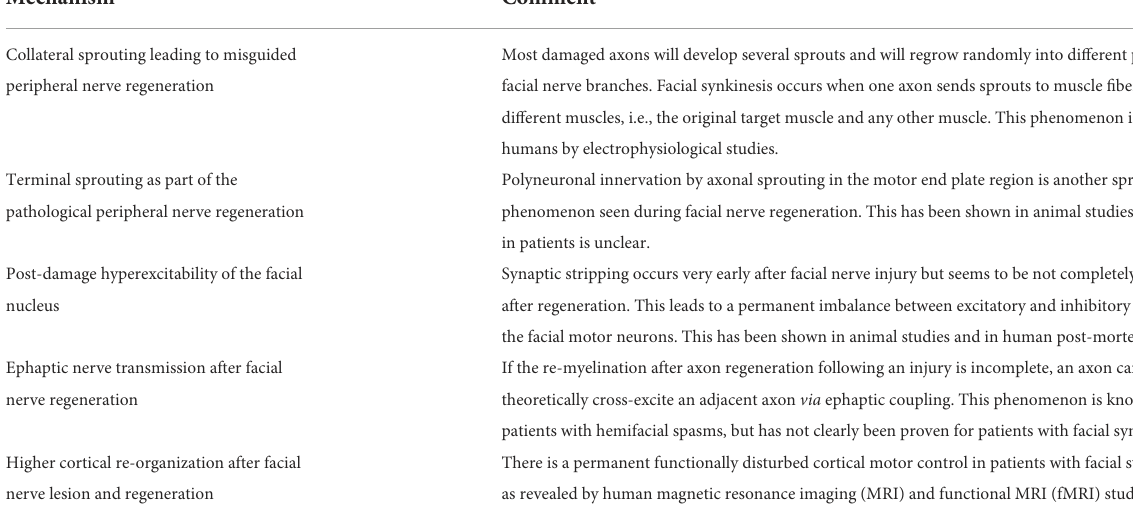
TABLE 1 Proposed elements of the pathomechanism of facial